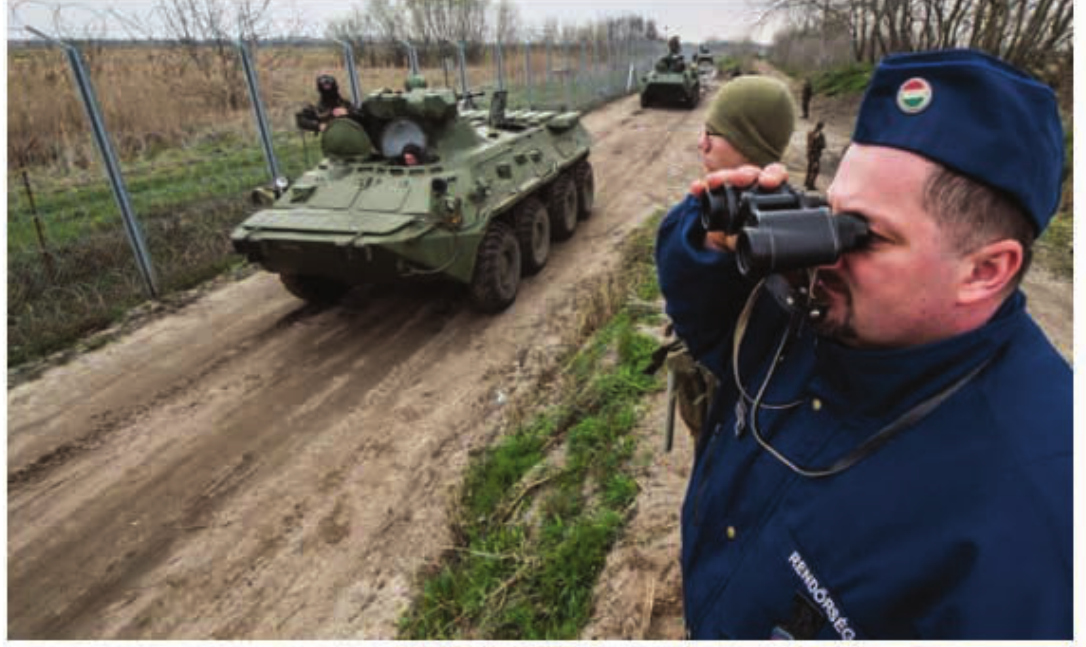
Figure 1: Hungarian troops on patrol earlier this year along the border fence Hungary erected to stop migrants and refugees, Photograph: Sandor Ujvari/EPA (GUA), https://www.theguardian.com/world/2016/aug/22/hungarian-mep-pig-heads-along-